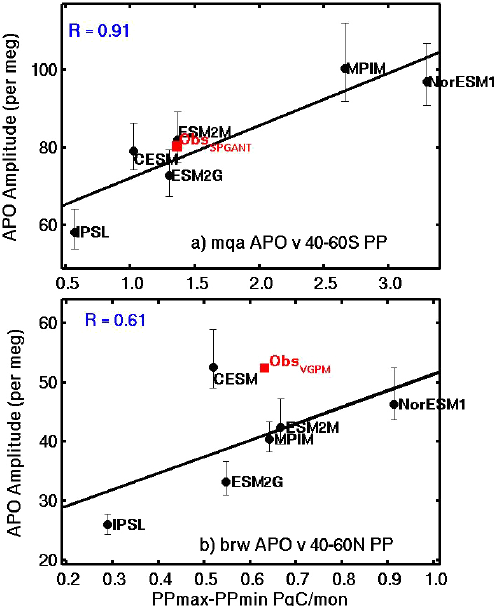
Figure 8. (a) Seasonal amplitude in APO at Macquarie Island (MQA), located at 54.5 ◦ S, 159 ◦ E, as estimated from the air–sea O 2 , CO 2 and heat fluxes from six ESMs, plotted against the sea- sonal amplitude of NPP integrated from 40 to 60 ◦ S. Error bars rep- resent the ATM uncertainty in model APO as estimated with the matrix method. The observed (Obs) data points (in red) are based on APO data from the PU network at MQA and NPP from the SP- GANT satellite ocean color algorithms, as described in the text. The correlation coefficient R refers to regression through ESM points only, (b) Same as 8a, but plotting seasonal amplitude in APO at Barrow, Alaska, against the seasonal amplitude of NPP integrated from 40 to 60 ◦ N. The observed data point is based on APO data from the PU network and the VGPM algorithm with MODIS-Aqua